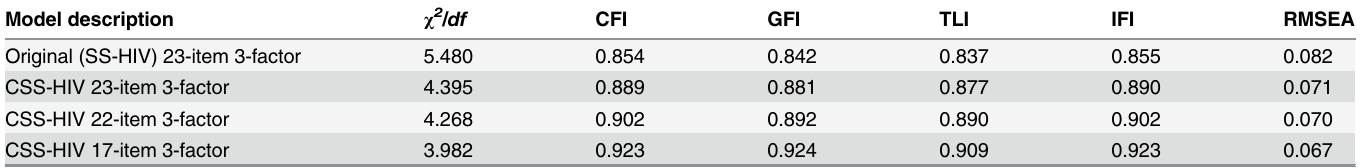
Table 1. Goodness of fit indices of the CFA models on the